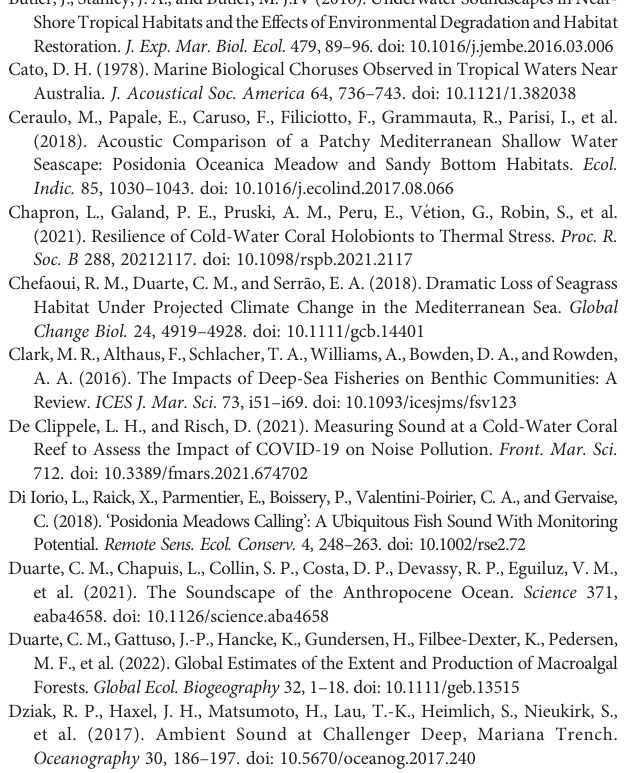
Supplementary Data Sheet 1 | Data analysis sheet of selected